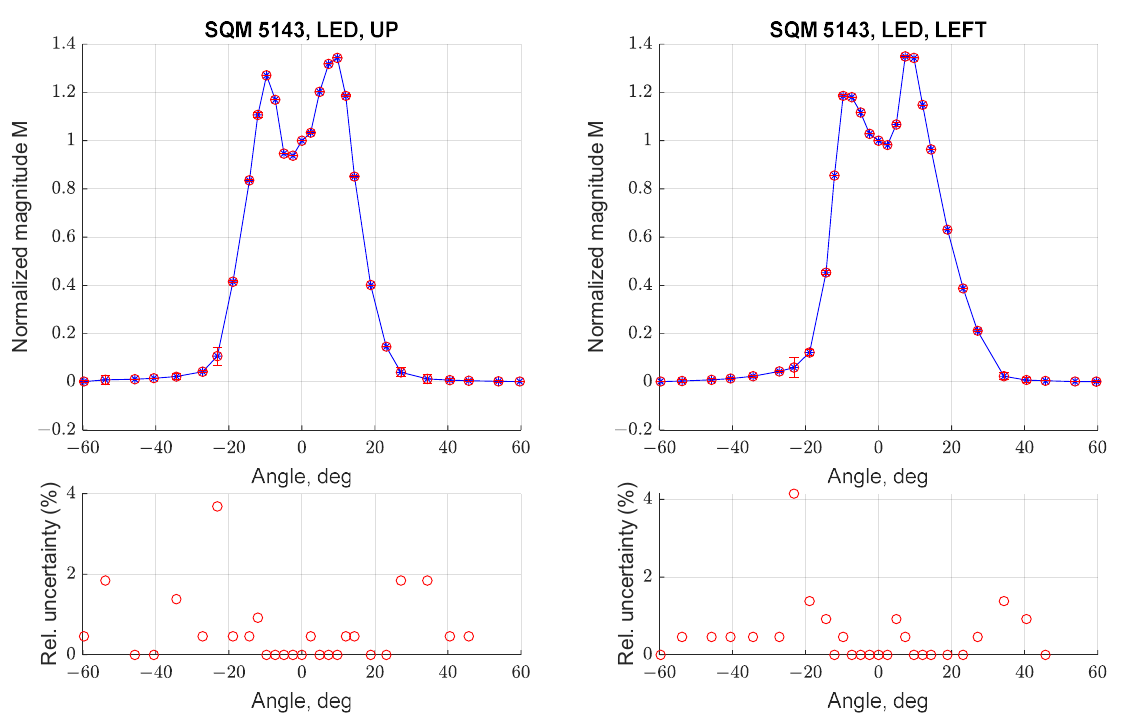
Figure 11. Normalized angular response curve ( top ) and relative uncertainty (1 σ , bottom ) for three scans performed with SQM-LE 5143 (UP and LEFT).